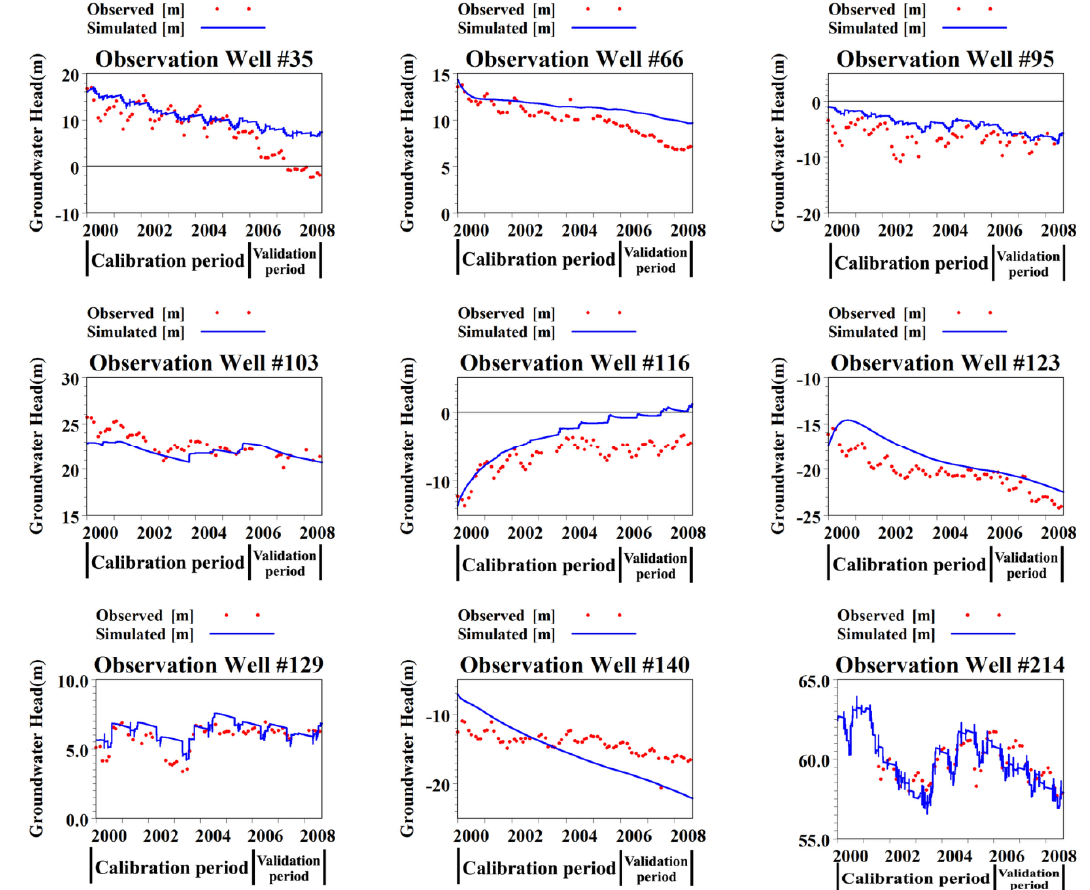
Fig. 5. Comparison of simulated and observed groundwater heads for selected observation wells distributed in the North China Plain. The calibration period is 2000–2005, while the validation period is 2006-2008.